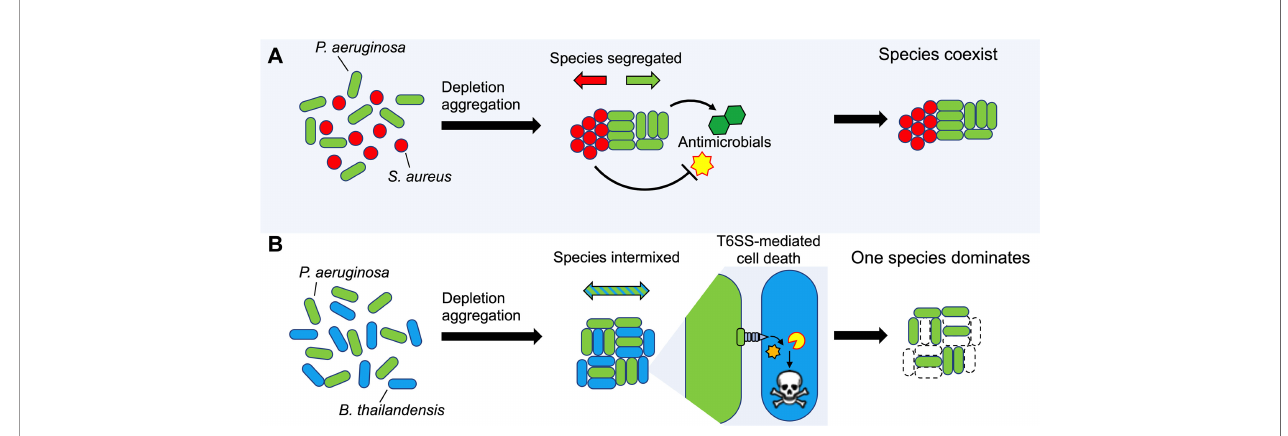
FIGURE 7 | Model depicting how depletion aggregation affects bacterial competition and species distribution in aggregates. (A) Depletion aggregation causes bacteria with different cell shapes to spontaneously segregate. When P. aeruginosa and S. aureus were co-cultured under conditions promoting depletion aggregation, S. aureus aggregates tolerated antimicrobials secreted by P. aeruginosa , promoting species coexistence. (B) When two rod-shaped species such as P. aeruginosa and B. thailandensis are aggregated by the depletion mechanism, species segregation is not observed and contact-dependent TSS-mediated killing is promoted, allowing P. aeruginosa to